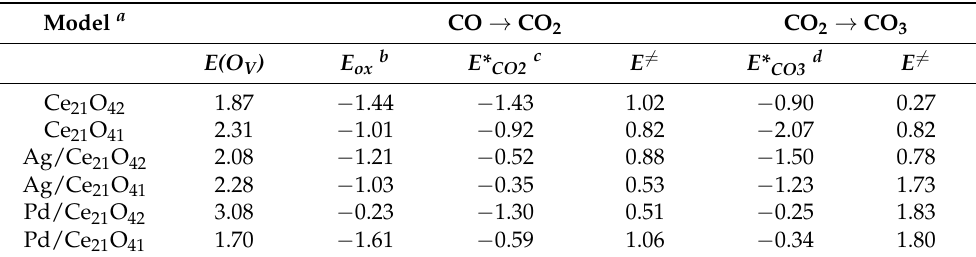
Table 2. Reaction and activation energies ( E (cid:54) = ) on the pristine ceria Ce 21 O 42 − n and metal–ceria M/Ce 21 O 42 − n models (M = Pd, Ag; n = 0, 1) depicted in Figures 2–4. Oxygen vacancy formation energies E(O V ) are also shown. Negative energy values correspond to exothermic processes. All energies are in eV.